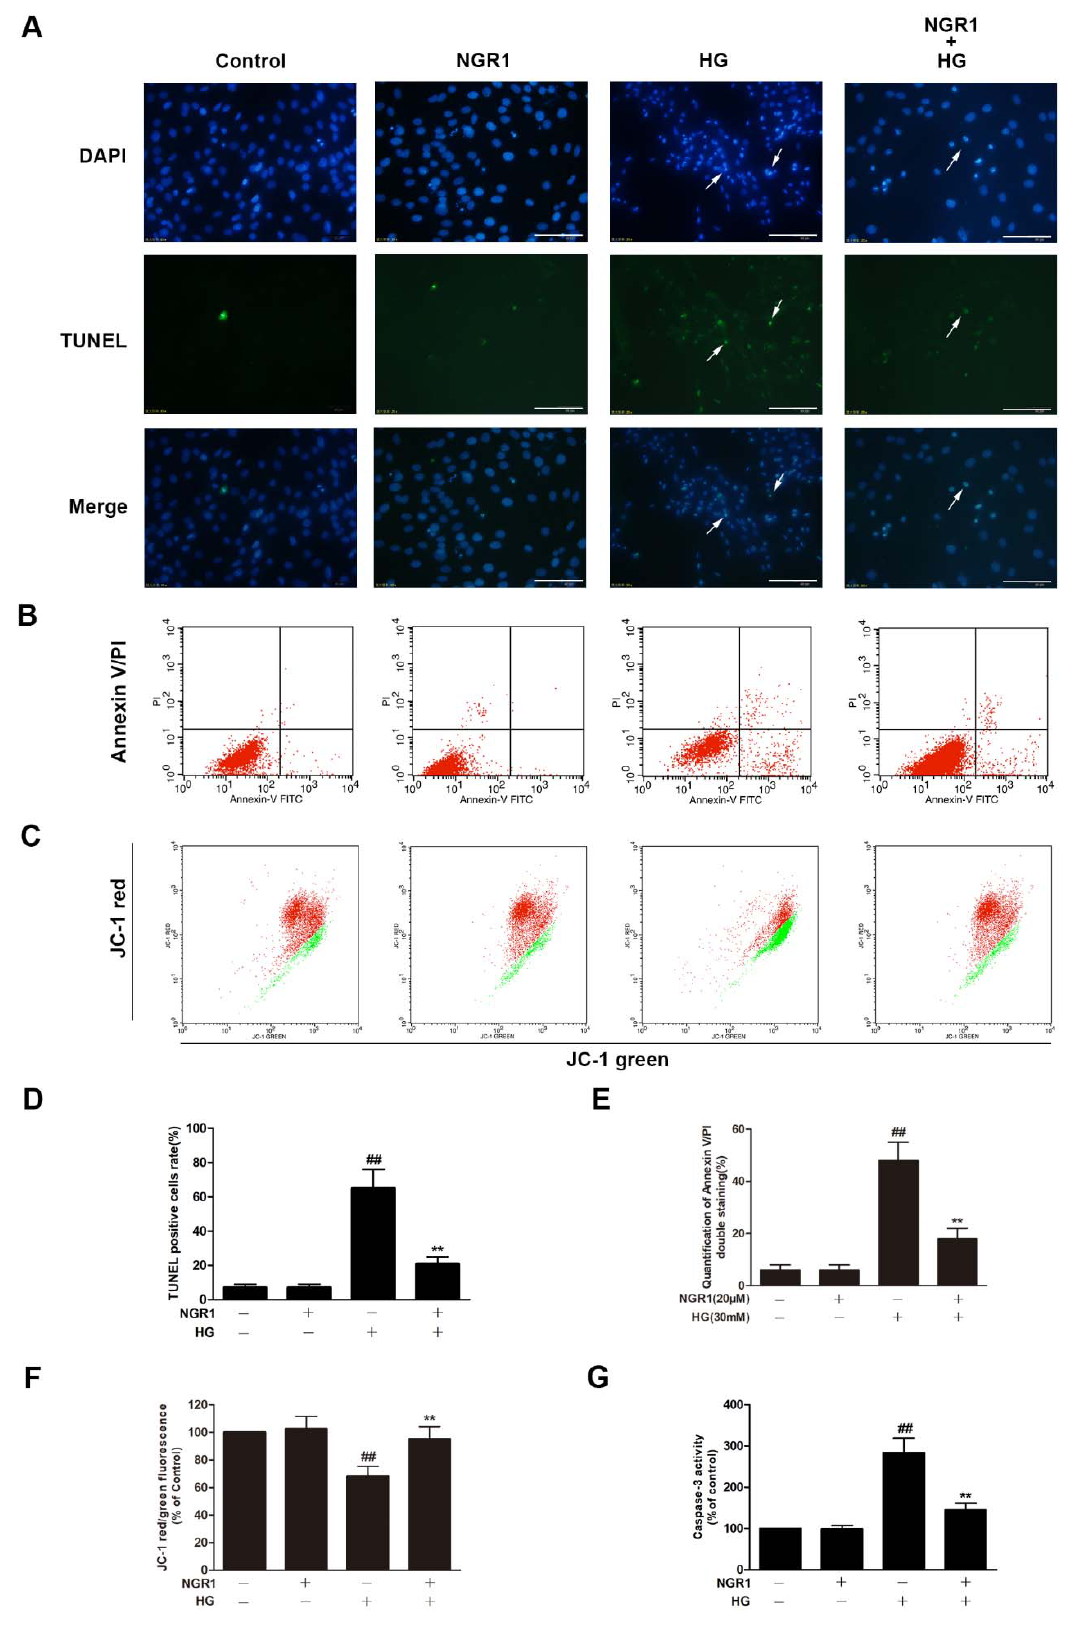
Figure 2. NGR1 preconditioning significantly inhibited HG ‐ induced apoptosis in rMC ‐ 1 cells. NGR1 preconditioning attenuated HG ‐ induced DNA fragmentation ( A ), Annexin V/PI double staining ( B ), and mitochondrial membrane depolarization ( C ) in rMC ‐ 1 cells. DNA fragmentation in rMC ‐ 1 cells was determined using TUNEL staining (bar = 100 μ m). Apoptosis rate was quantified with Annexin